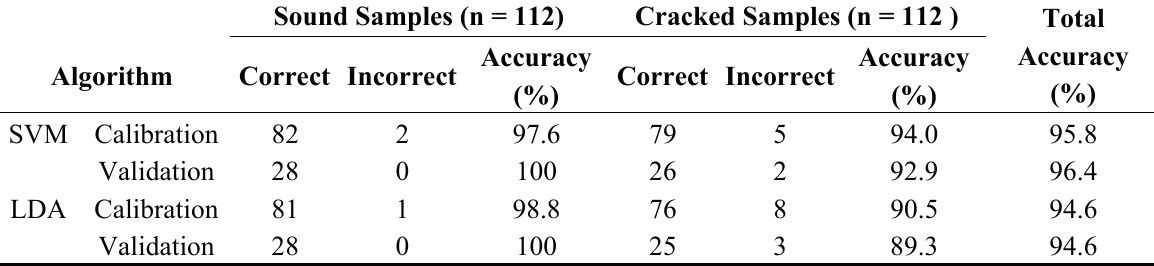
Table 1. Comparison of the results obtained using the SVM and LDA methods using two features obtained from the PLS binary images.